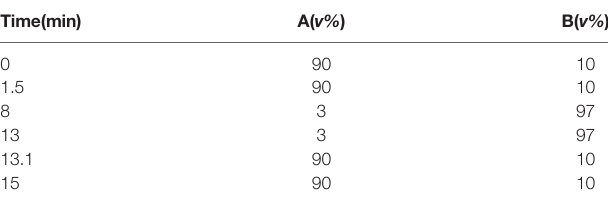
TABLE 3 | The gradient conditions for reversed phase C 8 separation for fatty acids.